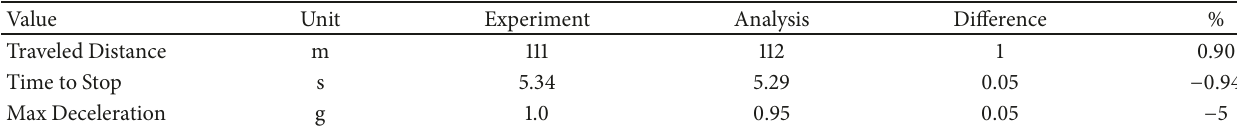
Table 2: A comparison of the numerical and experimental data.